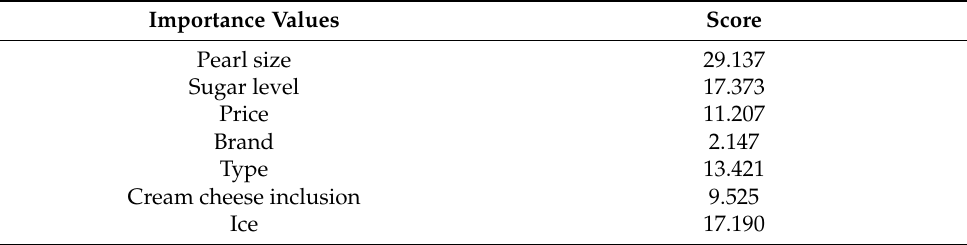
Table 5. Averaged importance